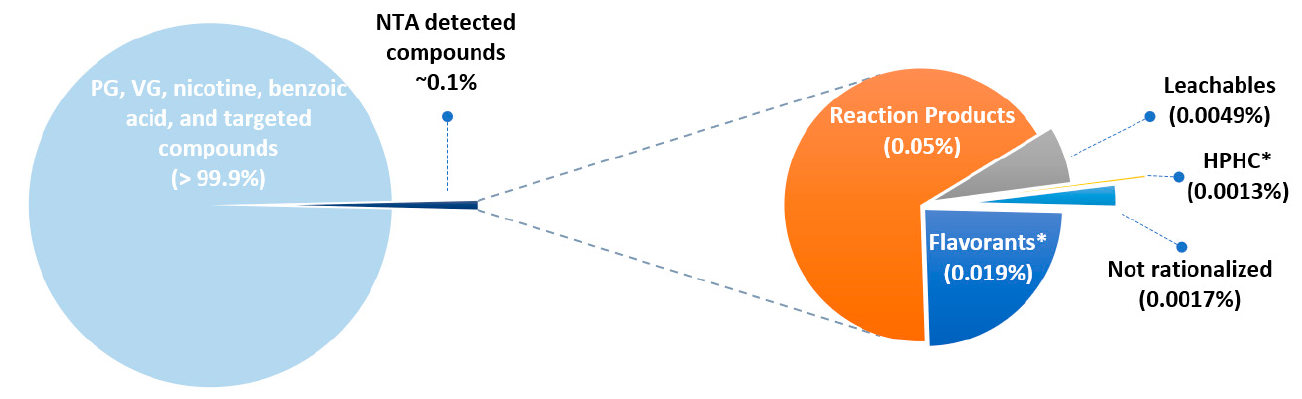
Figure 3. Percent total mass detected by GC and LC NTA methods under the intense and non-intense puffing regimens grouped by type for aerosol of Me3—the higher value from either intense or non-intense puffing results was used. See Tables 3 and 4 for more information. * Not detected by Chen et al. [58].